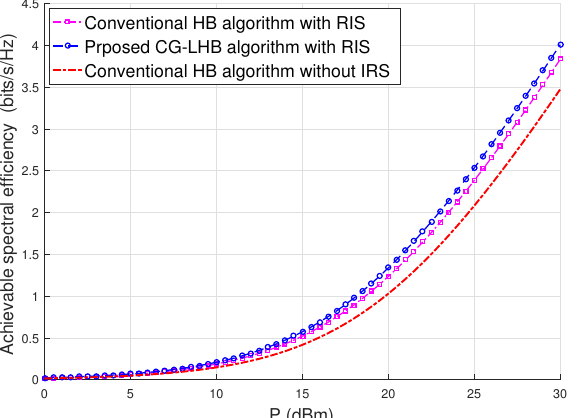
Conventional HB algorithm with RIS Prposed CG-LHB algorithm with RIS Conventional HB algorithm without IRS